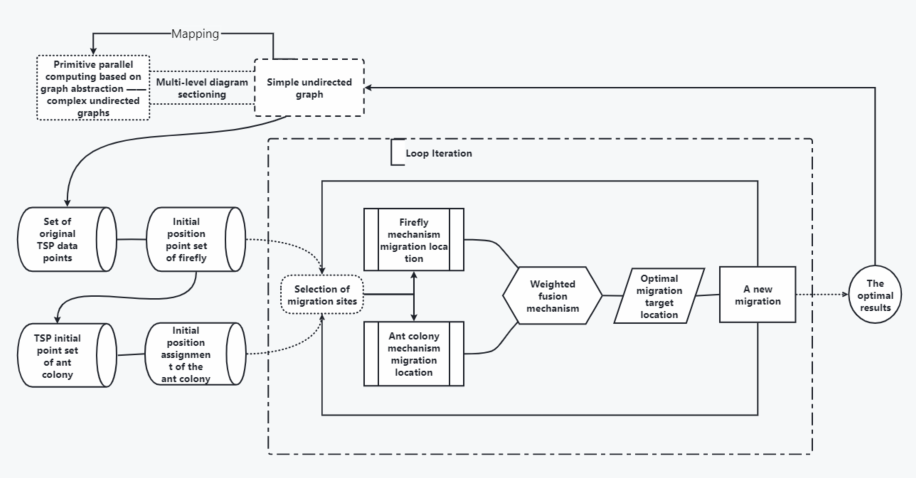
Figure 4. Logic diagram of the FaCO algorithm.